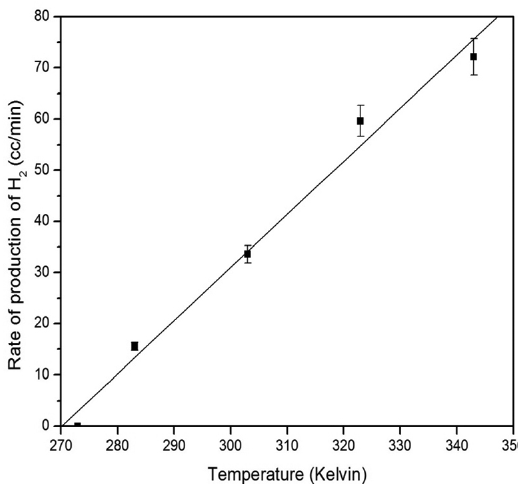
Figure 5. Effect of applied voltage on the production of hydrogen gas: Dimensional of graphite rod: 80 × 20mm; Temperature: 303 K; Pressure: 1 atm; Electrolyte concentration: 0.03 M; Reaction Time: 10 mts and Distance between the electrodes: 2